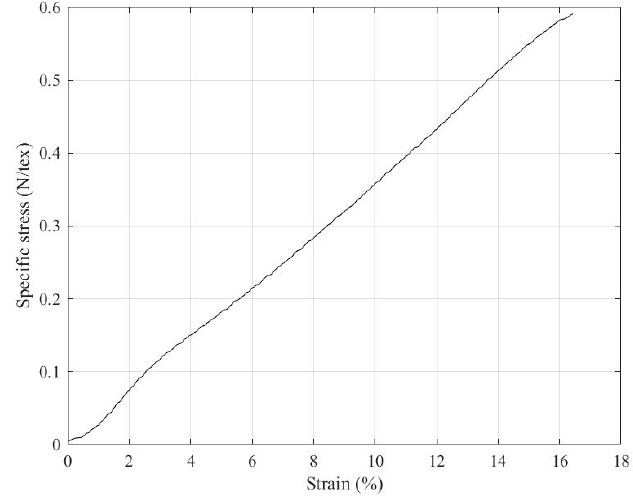
Figure 6. Stress-strain relationship for the polyester-polyolefin hybrid yarn.